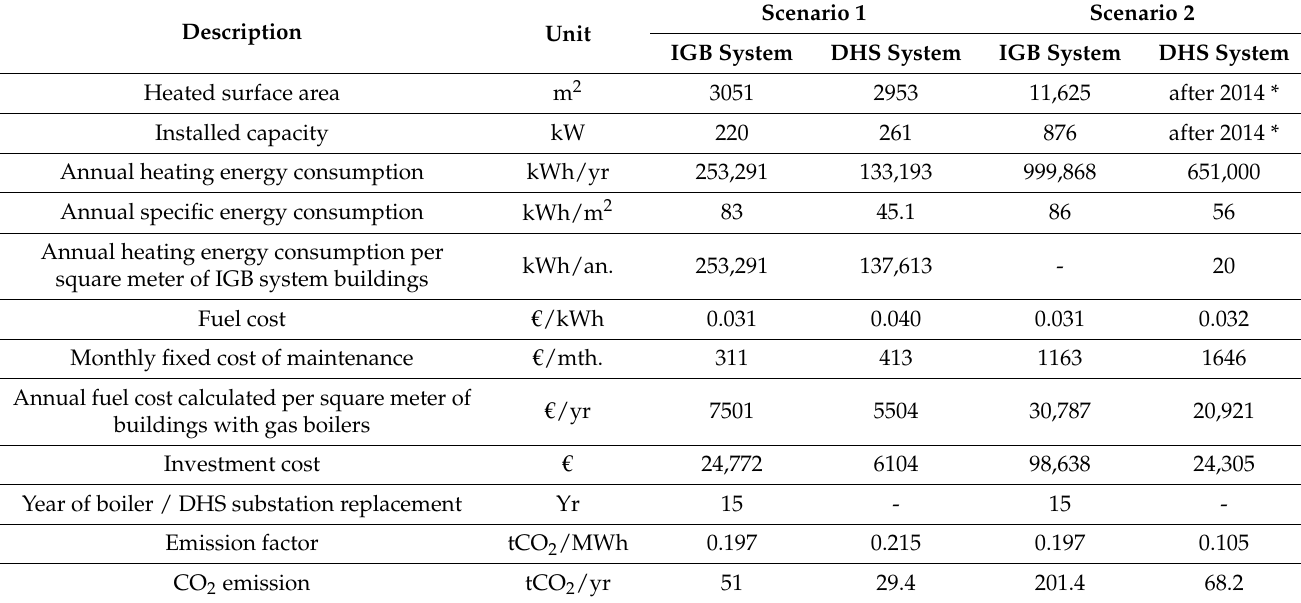
Table 5. Buildings data used for assessment in Scenario 1 and 2.